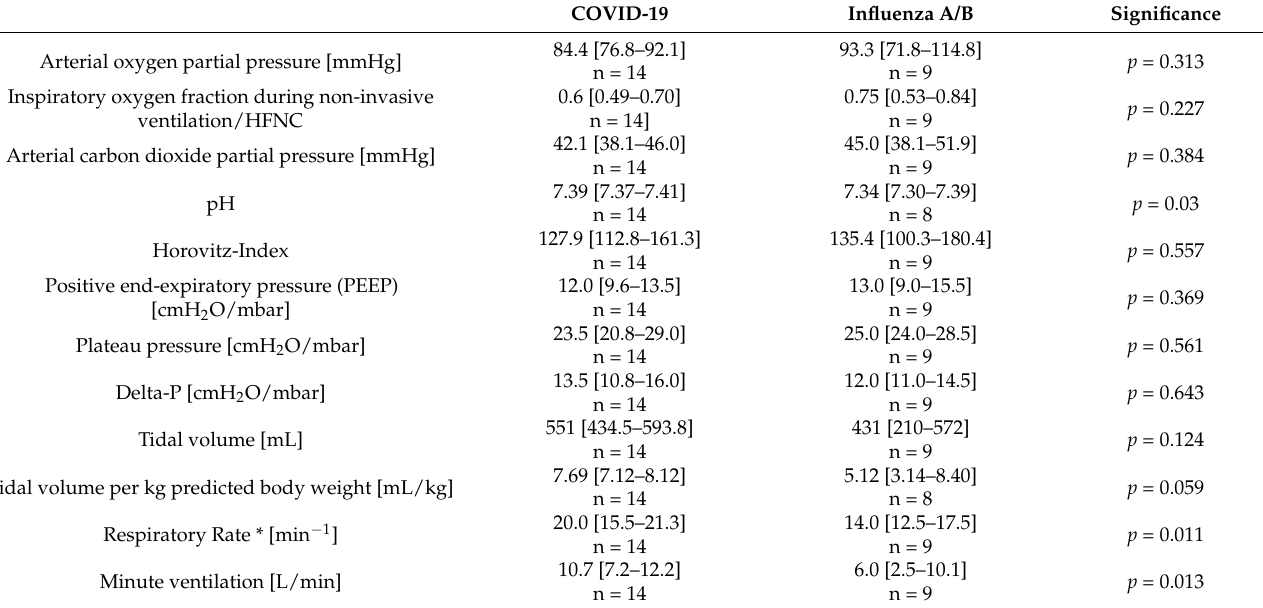
Table 2. Comparison of ventilation parameters on the first day of invasive ventilation.